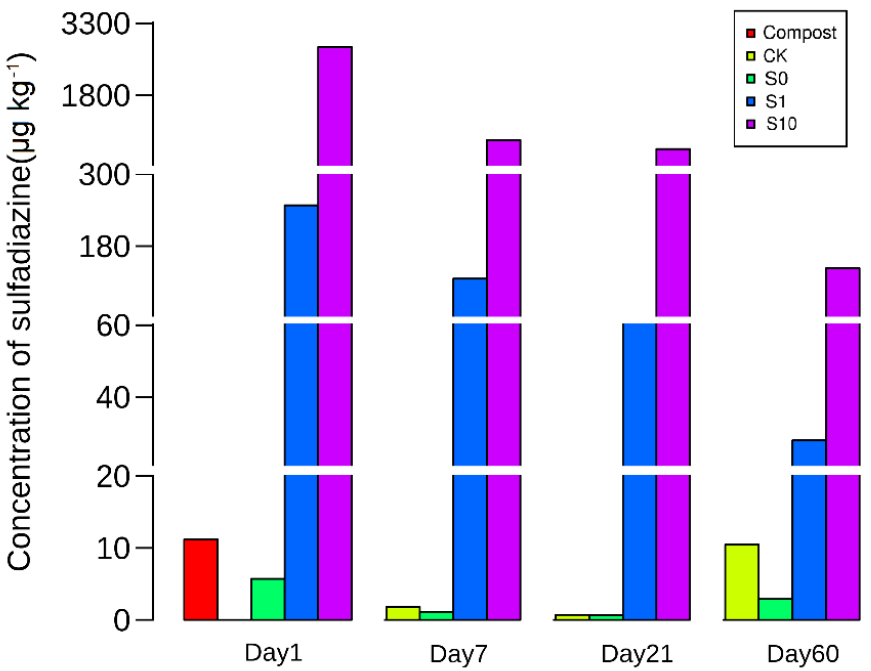
Figure 1. The concentration of sulfadiazine in compost and soils in different treatments. CK: soil; S0: soil amended with compost; S1: soil amended with compost and 1 mg kg − 1 of sulfadiazine; S10: soil amended with compost and 10 mg kg − 1 of sulfadiazine.